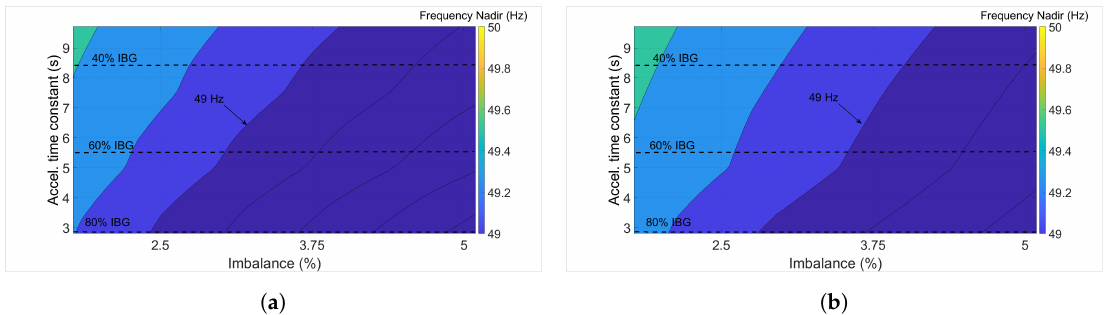
Figure 11. ( a ) Frequency nadir of the European-scale with only synchronous reserve. ( b ) Frequency nadir of the European-scale model with 40% of the IBG equipped with synthetic inertia